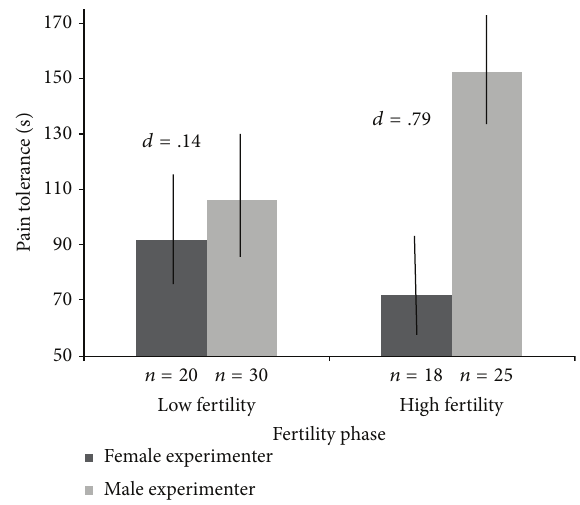
Figure 1: Plot of significant fertility × experimenter gender inter- action for pain tolerance in naturally cycling women. Higher values on the 𝑦 -axis indicate lower pain sensitivity. Fertility phases are represented by values lower than and greater than the mean probability of conception based on the women’s current cycle day. Bars indicate standard errors of the